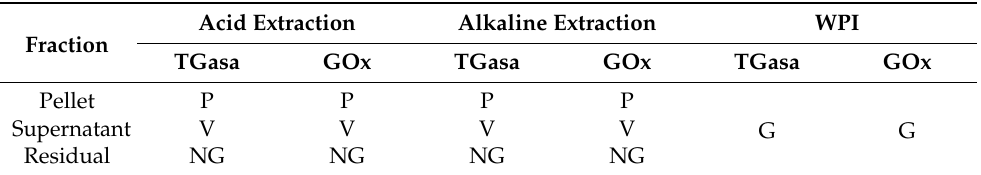
Table 2. Visual evaluation results of cricket protein fractions and whey protein isolate (WPI) treated with enzymes, heat and HHP.